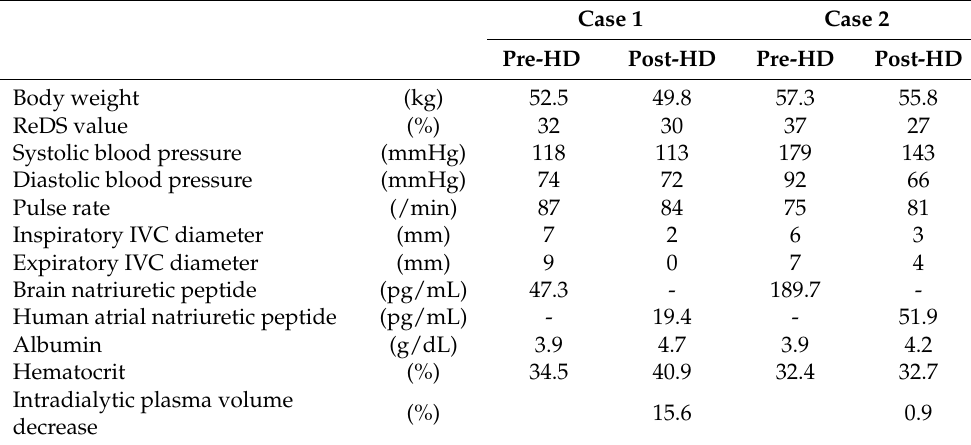
Figure 3. The trend of vital signs and fluid removal during hemodialysis in case 1. Table 2. Trends in clinical parameters during hemodialysis.